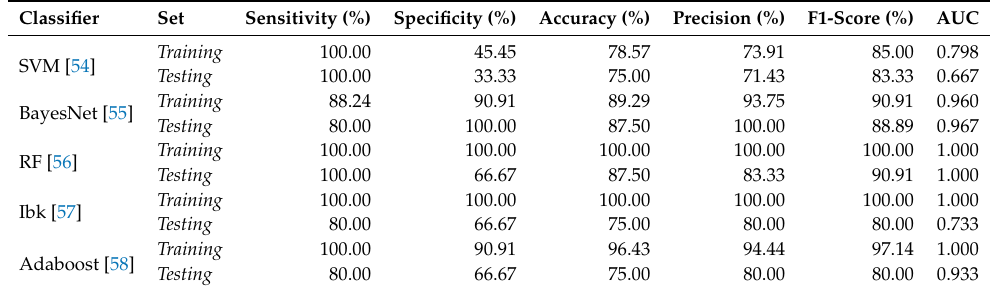
Table 4. Results obtained considering clean ECG signals in the training and testing sets ( scenario 1 ).